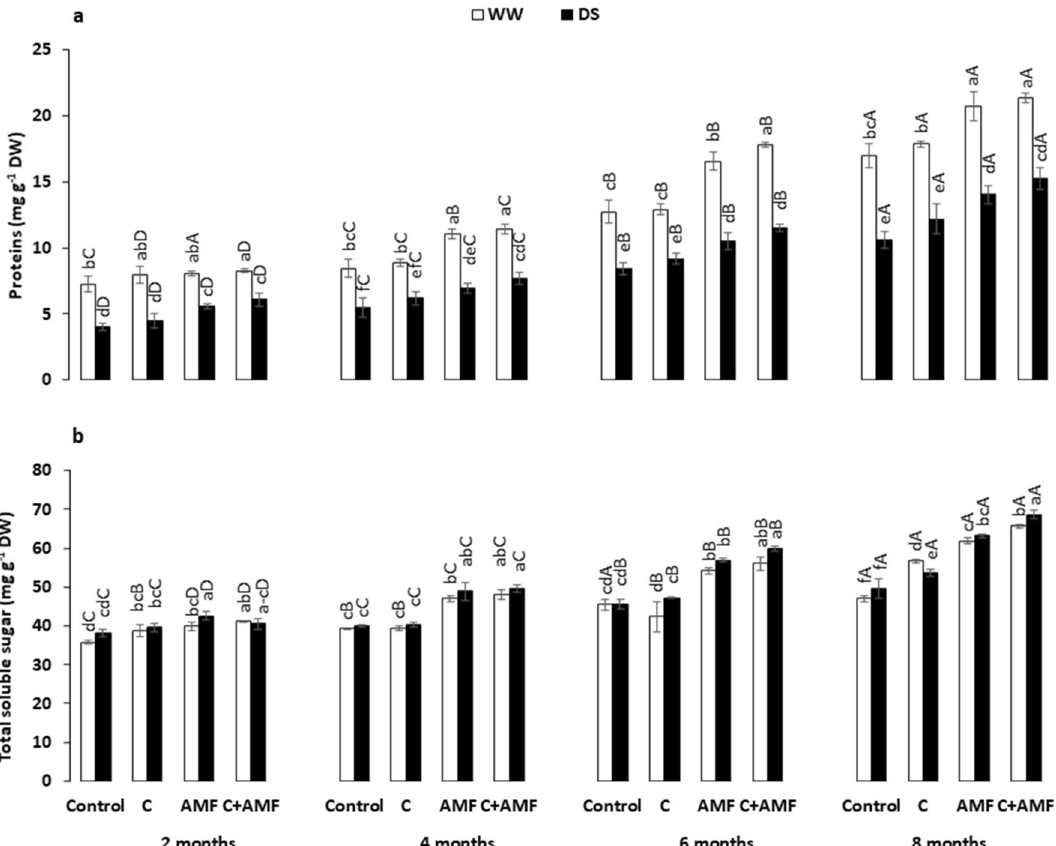
Figure 5. Influence of water regimes (WW: well-watered; open bars and DS: drought stress; filled bars) on ( a ) proteins and ( b ) total soluble sugars in control carob plants and plants amended with compost (C) and/or assemblage of indigenous arbuscular mycorrhizal fungi (AMF). Data are mean ± SE (n = 5). Means followed by the same letters within the same time point are not significantly different at P < 0.05 (Tukey’s HSD). The upper case represents the differences within WW or DS water regime, and the lower case represents the differences within a one-time In this study, no mycorrhizal structure was observed in the roots of non-inoculated carob seedlings, but the native mycorrhizal consortium successfully infected the AMF and C + AMF young carob. Several studies showed that root colonization decreased in the host plants under drought stress 65,66 . A short-term soil drought did not appear to discourage root colonization 20 , whereas a long-term soil drought considerably decreased root coloniza- tion and hyphal growth 67–69 . It is worth noting that the native soil composition and host plant genotype are also considered important in the recruitment of microbiome by the host plant. The functional profile of the microbial communities might be correlated with changes in community composition at the species level, suggesting that ‘suitability phenomena’ between the host plant and its native microbial communities, rather than a “generalistic” inoculum, may be functionally driven rather than driven by phylogeny 70 . Previous studies reported the effective- ness of native inoculum, which promotes and maintains plant growth despite the low colonization percentages under abiotic stresses 22,26,57 . Essahibi et al . 72 reported that long-term drought stress decrease root colonization in carob seedlings inoculated with Rhizophagus intraradices, R. fasciculatus and Funneliformis mosseae . Further- more, several studies showed that environmental conditions such as soil nutrition, moisture, temperature, and host genotype and age directly influence root and leaf microbial communities 73–79 . Our results showed that the application of green waste compost in sandy soil favored the spore production of the native AMF consortium, thereby improving the infectious propagules of carob plants. This may be related to the inherent capacity of the used consortium to sporulate or favorable interaction, due to C availability, with the carob host plant. Chaiyasen et al . 78 showed that inoculation with indigenous AMF consisting of Claroideoglomus etunicatum, C. etunicatum , and Funneliformis mosseae in sandy soil amended with green waste compost containing 214 mg/Kg P improved spore numbers and the infectious propagule production in maize. Our results indicated that compost addition enhanced root colonization after long-term (after six months) compared to plants treated with AMF alone under DS. These results were consistent with previous studies reporting that compost and/organic amendment addition most often positively affected AMF growth under DS 25,78,80 . Several research had confirmed that water status in dry soil strongly altered AMF spore survival and germination and inhibited the spread of hyphae 67,81,82 . AMF exclusively found in the native habitat of wild relatives of crop plants comprise representatives of Glomus , Rhizo- phagus , Funneliformis , Acaulospora , Entrophospora , Gigaspora, and Scutellospora . The genus Glomus and Glomus